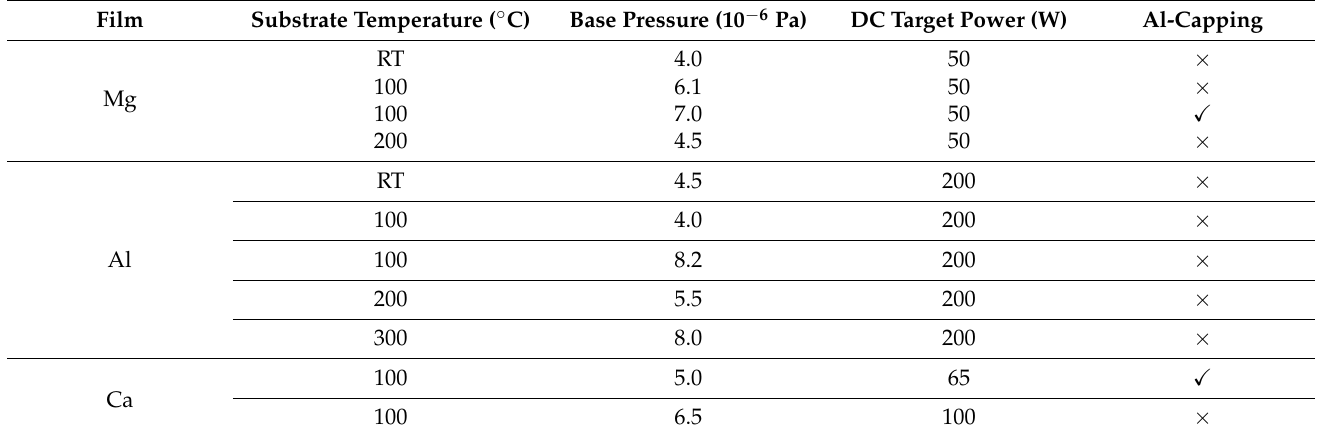
Table 1. Synthesis parameters of thin films deposited within this study. Room temperature is denoted as RT. The Ar partial pressure was kept constant for all depositions at 0.5